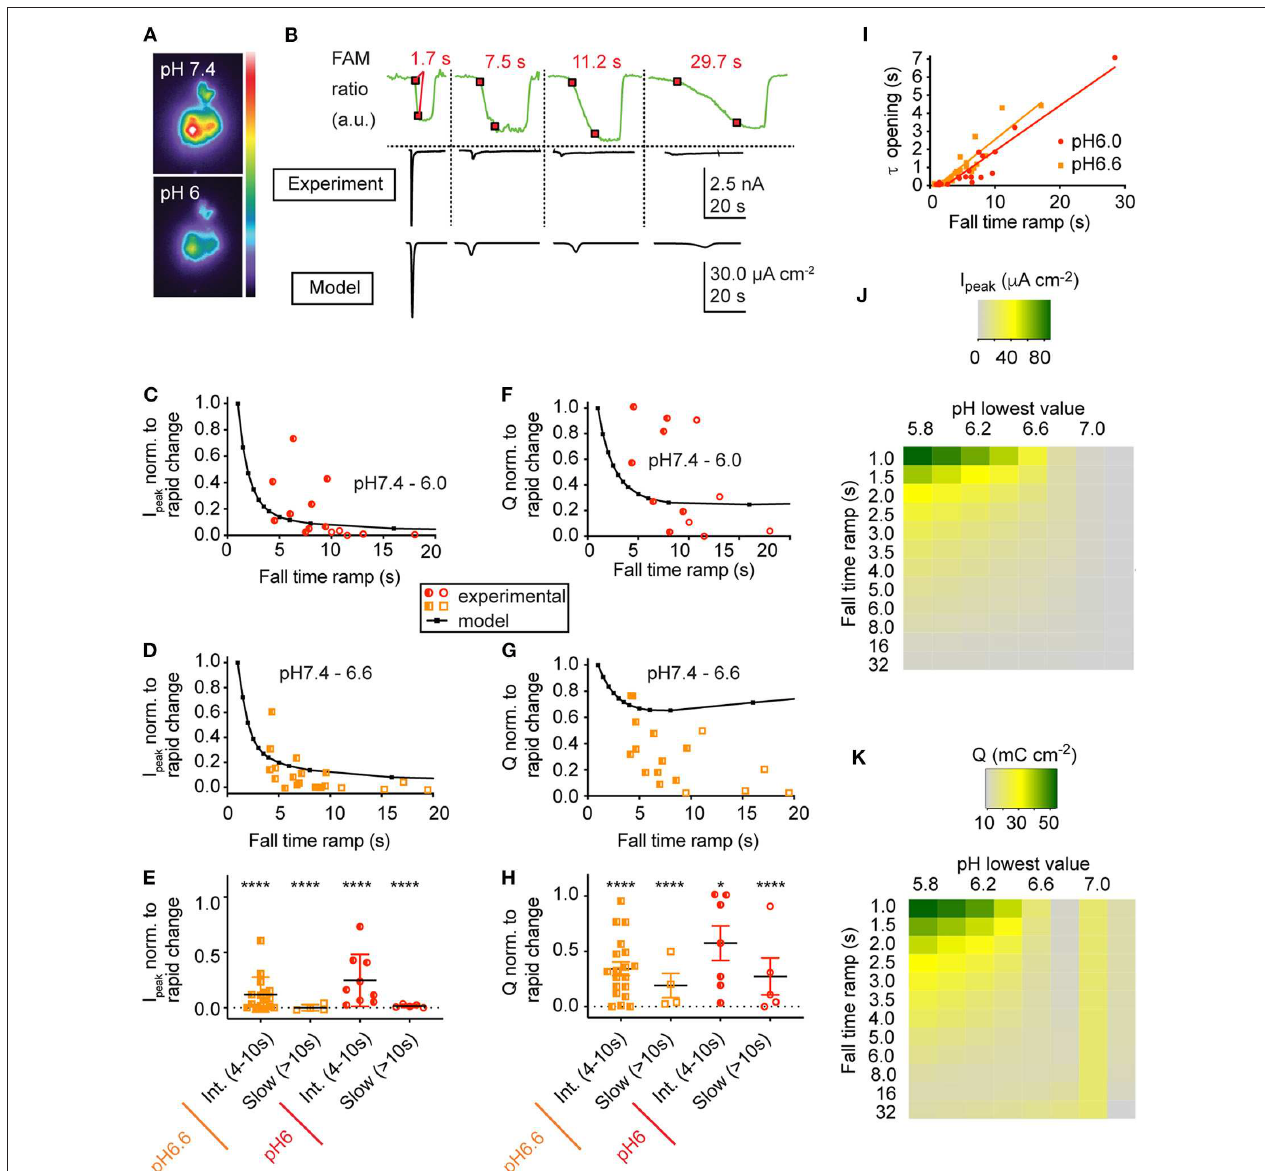
FIGURE 4 | Slowing of the pH change reduces the current amplitude and the transported charge. (A) Pseudocolor image by the pH-sensitive fluorescent dye 5(6)-FAM of the same cell at pH 7.4 and at pH 6.0. (B) Fluorescence intensities (green traces, upper panel) as a function of time in response to pH ramps of different speed from pH 7.4 to pH 6.0. The 10–90% fall-time (FT) of the fluorescence change corresponds to the interval between the two red squares (Materials and Methods). Each fluorescence trace (top panel) was measured simultaneously with the corresponding ASIC1a current trace (middle panel). Bottom panel, traces created by the kinetic model in response to the above pH ramps. The experimental data in (B–I) are from whole-cell patch-clamp at − 60mV. (B–H) Current and transported charge values are normalized to the corresponding response measured in the same cell to a rapid pH change (ramp FT < 4s). (C,D) ASIC1a peak current amplitudes in response to pH 7.4–6.0 ramps (C) or pH 7.4–6.6 ramps (D) of different duration, shown as function of pH ramp FT ( n = 14–20). The model prediction is indicated with black symbols and the connecting line. (E) Normalized peak current amplitudes for ramp durations classified into intermediate (ramp FT 4–10s) and slow (ramp FT > 10s; n = 4–16). **** p < 0.0001, different from rapid change (ANOVA, Tukey post-hoc test). (F,G) Transported charge (Q), the current integral over time, is indicated for the same protocols as shown in (C,D) ( n = 12–17). The model prediction is indicated with black symbols and the connecting line. (H) Normalized transported charge for ramp durations classified as in E ( n = 4–16). * p < 0.05; **** p < 0.0001, different from rapid change (ANOVA, Tukey post-hoc test). (I) Time constant of ASIC current appearance in pH 7.4–6.0 (red symbols) and pH 7.4–6.6 ramps (orange), plotted as a function of the pH ramp FT. The r 2 values were 0.906 ( p < 0.001, pH 7.4–6.0 ramps) and 0.846 ( p < 0.001, pH 7.4–6.0 ramps), n = 21–29. (J,K) Heat map of the simulated peak ASIC1a current (J) or charge transport (K) as a function of the pH ramp lowest value (pH) and duration (FT) in seconds. Shown are the amplitude of the maximal current (I peak , µ A cm − 2 ) and the transported charge (Q, mC cm − 2 ) according to the scaling